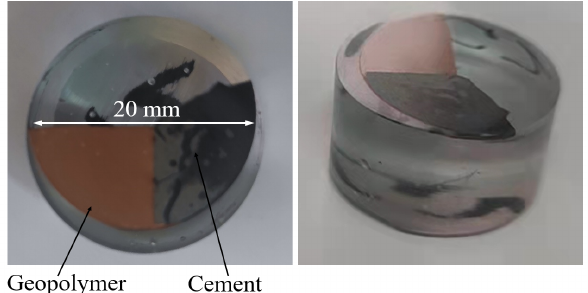
Figure 5. Sample preparation for the BSE test.